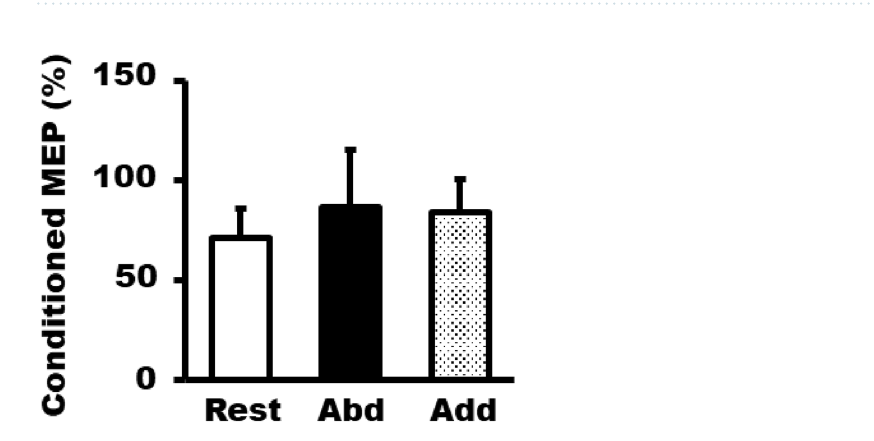
Figure 4. Average ± SD of F-wave persistence ( A ) and F/M amplitude ( B ) from the FDI muscle during MI + AO of abduction (abd), adduction (add), and rest phases. ( * p < 0.05).